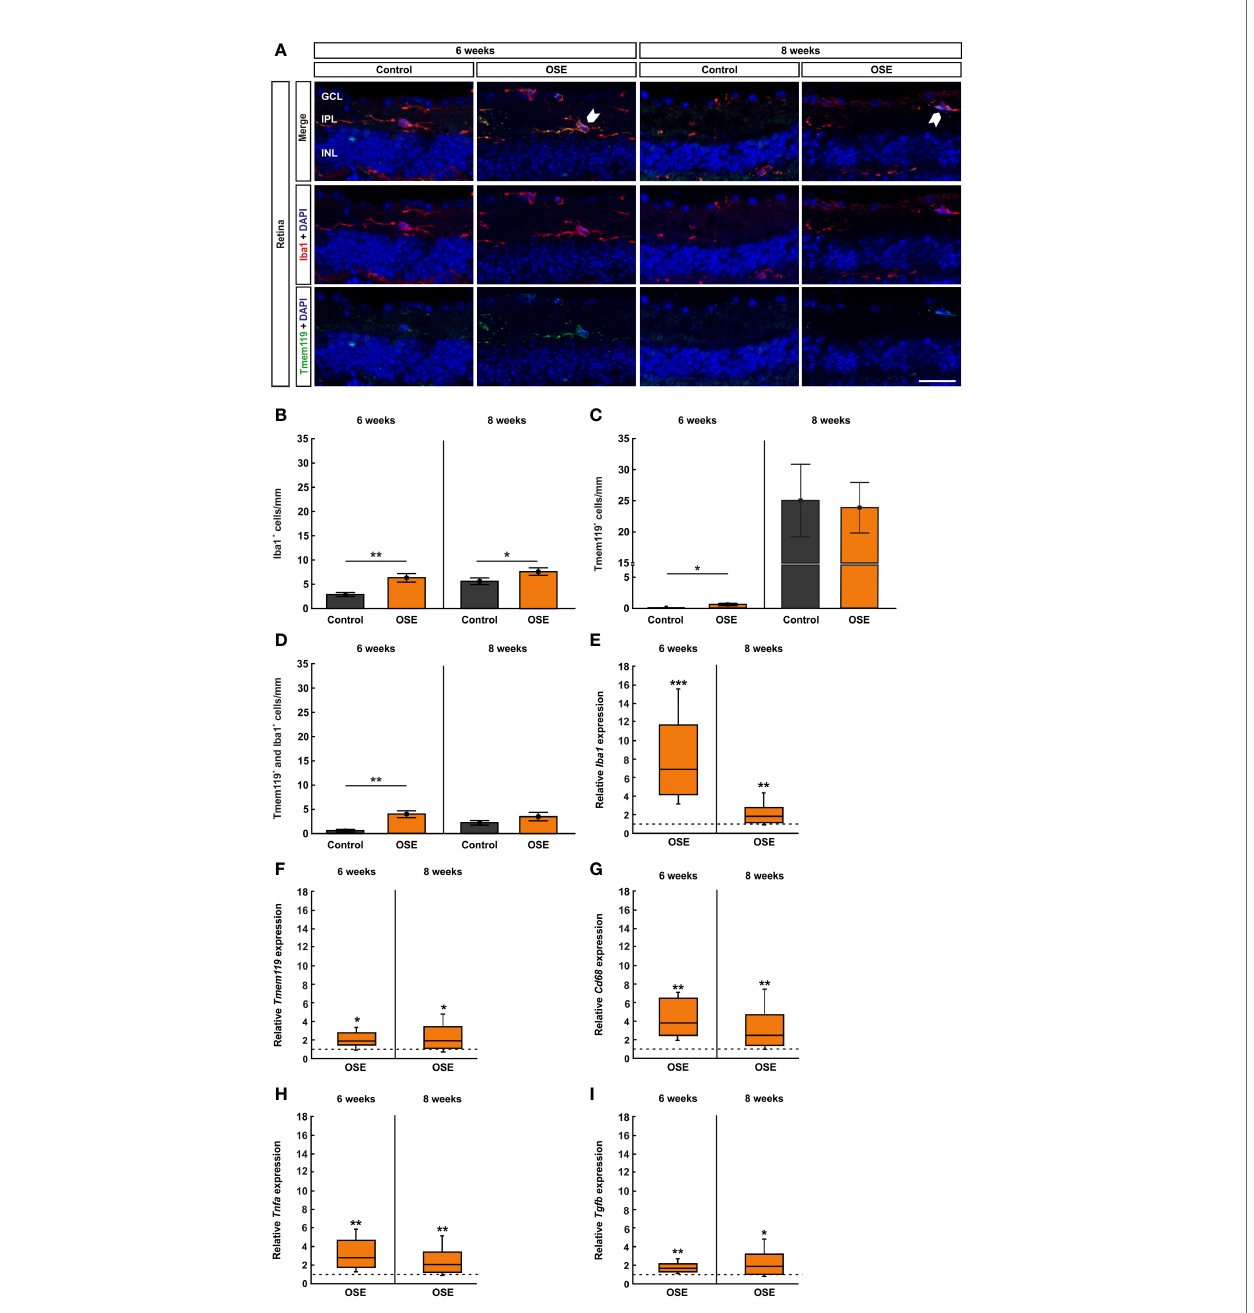
FIGURE 6 | Increased number of microglia/macrophages in OSE retinae. (A) Iba1 was used to label microglia/macrophages (red) whereas microglia were co- stained with Tmem119 (green) and Iba1. Iba1 + and Tmem119 + cells were quanti fi ed in GCL, IPL, and INL. White arrows point towards co-localized Tmem119 + and Iba1 + cells. (B) The immunohistochemical staining of the retina after six weeks demonstrated a signi fi cantly increased number of microglia/macrophages (Iba1 + ) in OSE mice. The number of Iba1 + cells was also signi fi cantly increased in eight-week-old OSE mice. (C) An increased number of Tmem119 + cells was noted in the retinae of OSE animals at six weeks. Tmem119 + cell counts were comparable in both groups at eight weeks. (D) The number of Tmem119 + and Iba1 + cells in the retina was signi fi cantly increased in the OSE group at six weeks, which was diminished at eight weeks. (E) Using RT-qPCR, a signi fi cant upregulation of Iba1 mRNA was noticed in six-week-old OSE mice. After eight weeks, the expression of Iba1 mRNA was still signi fi cantly increased, though to a lesser extent. (F) The expression of Cd68 mRNA was signi fi cantly increased in OSE retinas at both time points. (G) The mRNA expression of Tmem119 was also elevated after six and eight weeks. (H) RT-qPCR evaluation of the cytokine Tnfa mRNA revealed an increased expression at both ages in OSE mice. (I) The Tgfb mRNA expression was signi fi cantly upregulated at six and eight weeks in the OSE group. Data are shown as mean ± SEM for immunohistochemistry, relative values for RT-qPCR are median ± quartile ± maximum/minimum. The dotted lines in (E – I) represent the relative expression level of the control group. GCL, ganglion cell layer; IPL, inner plexiform layer; INL, inner nuclear layer. *p < 0.05, **p < 0.01, ***p < 0.001. Scale bar: 20 m